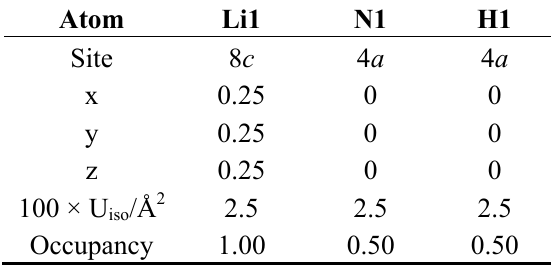
Table 5. Atom positions used for Rietveld refinement against PXD data for HT-Li sample 8) at 298 K. (Thermal parameters were fixed for this minority